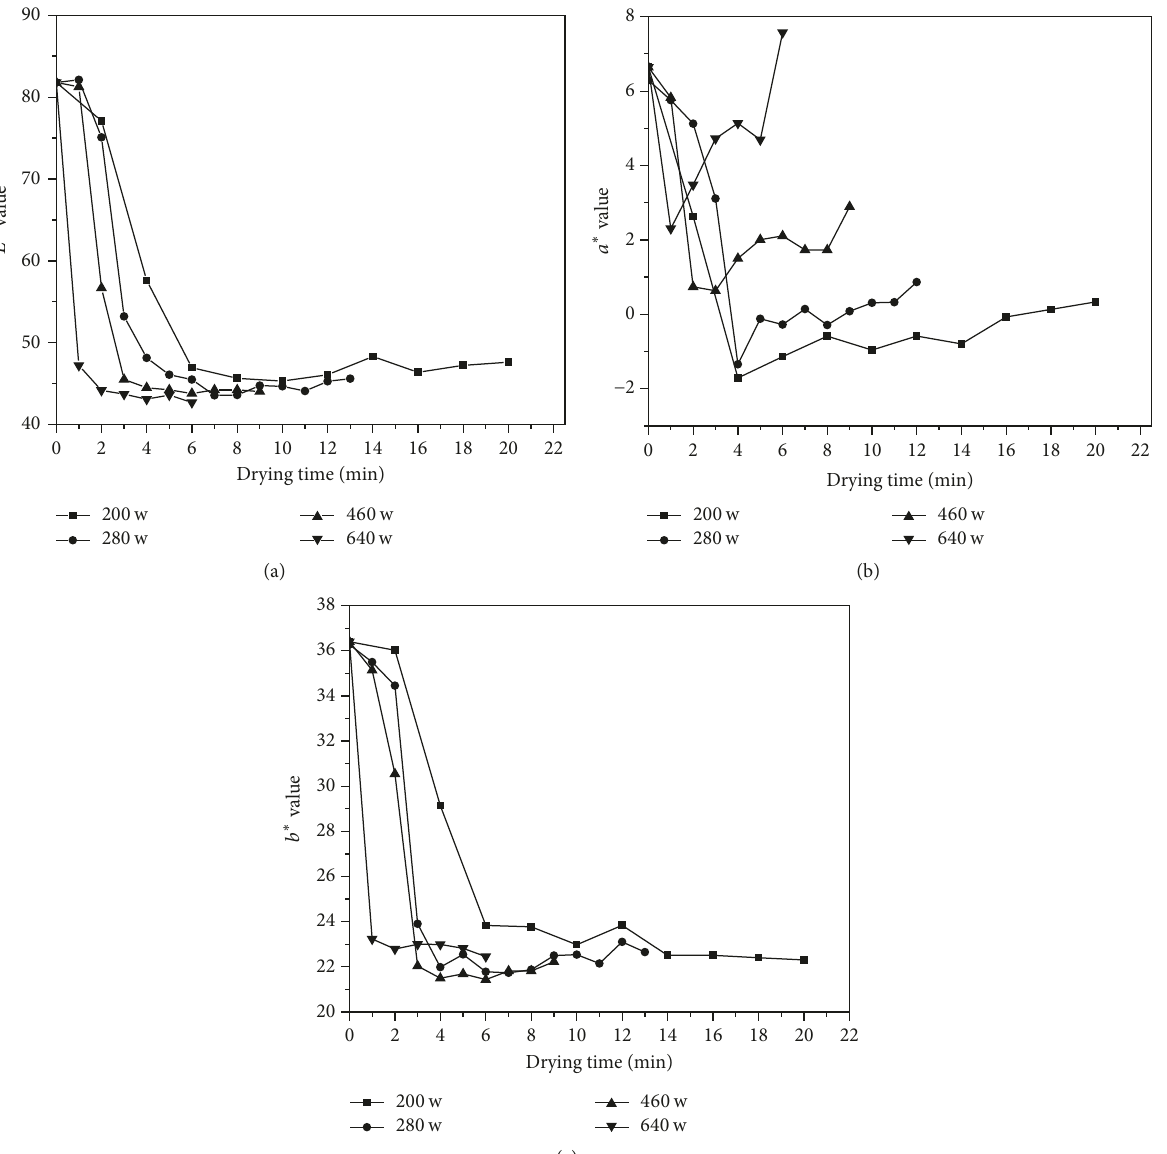
Figure 4: Color changes of (a) 𝐿 ∗ value, (b) 𝑎 ∗ value, and (c) 𝑏 ∗ value as a function of drying time at various microwave powers for sample amount of